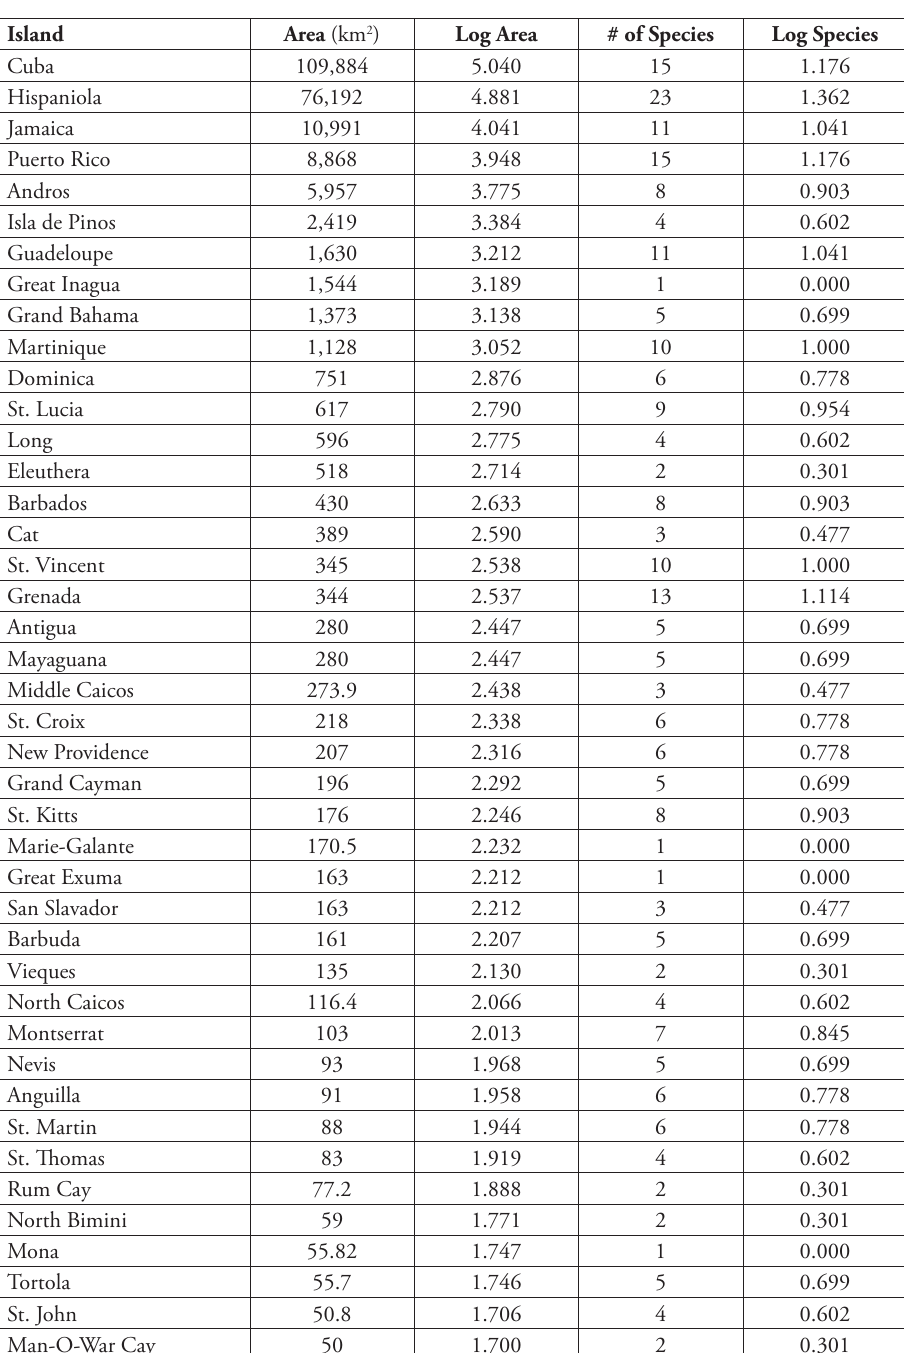
Table 4. Data for island area and number of Selenophori species collected on each of those islands (76 in total), plus log of land area and log of number of species which were used to generate Figure